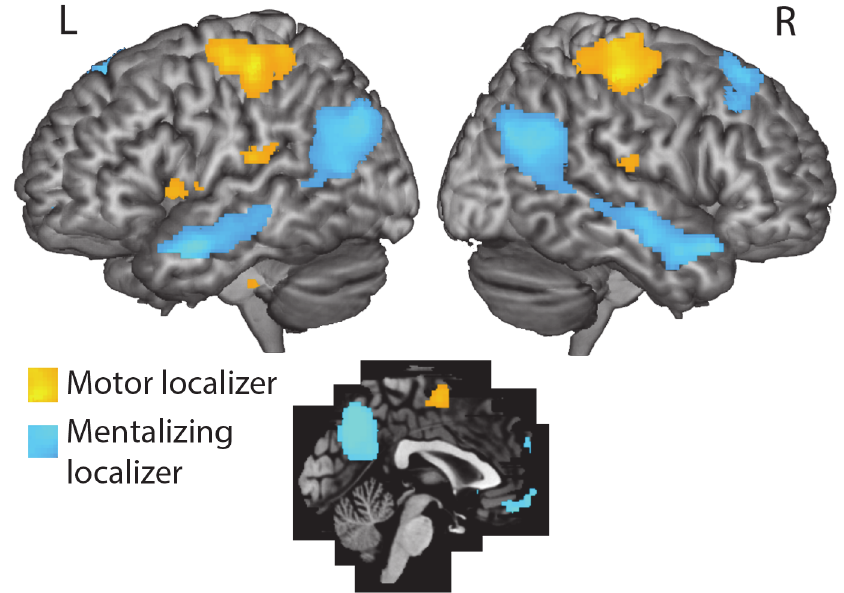
Fig 1. Results of the localizer scans. Whole-brain analysis results for the action localizer scan in yellow (hand action execution versus rest), and for the mentalizing localizer in blue (false belief stories versus false photograph stories [34]). The action localizer activated the cortical motor system robustly, and the mentalizing localizer led to activations in the previously defined mentalizing (or Theory-of-Mind) network. Areas from the localizers were used in the main analysis as regions of interest. Results are displayed at a statistical threshold level of p < 0.05, corrected for multiple comparisons.